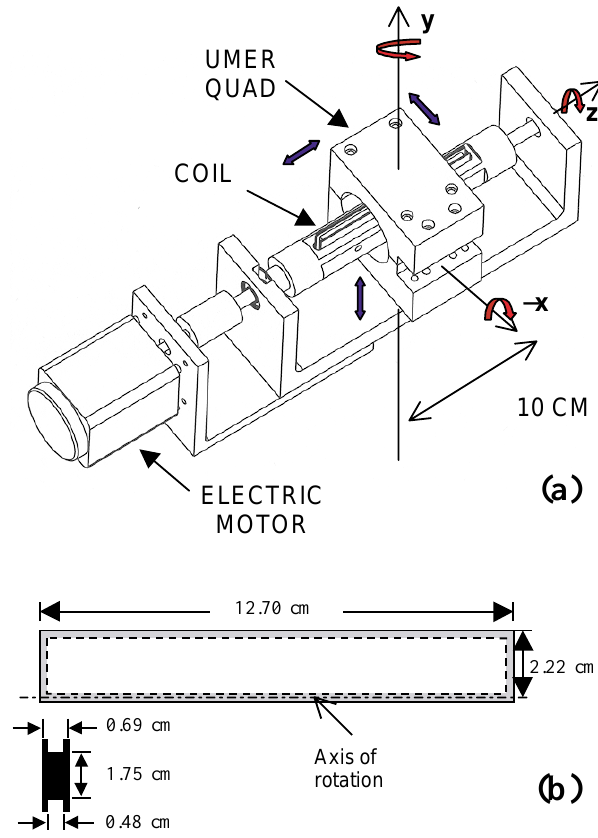
FIG. 5. (Color) (a) Schematic of rotating coil apparatus. The magnet mount is attached to plates not shown in the drawing. (b) Coil dimensions. In (a), the solid arrows indicate the possible adjustments of the magnet relative to the coil. The whole of the rotating coil apparatus is normally enclosed in a mu-metal